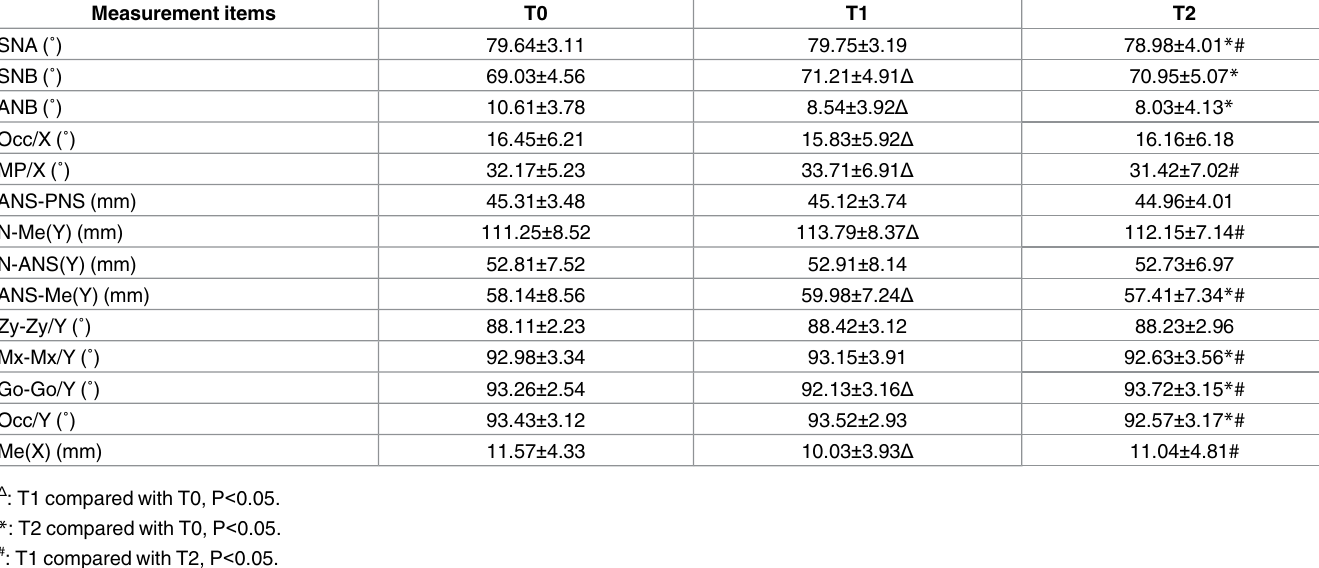
Table 1. The integral items of craniofacial hard tissue structure at the three time points before and after autogenous coronoid process graft recon- struction for the treatment of unilateral temporomandibular joint ankylosis. Measurement items